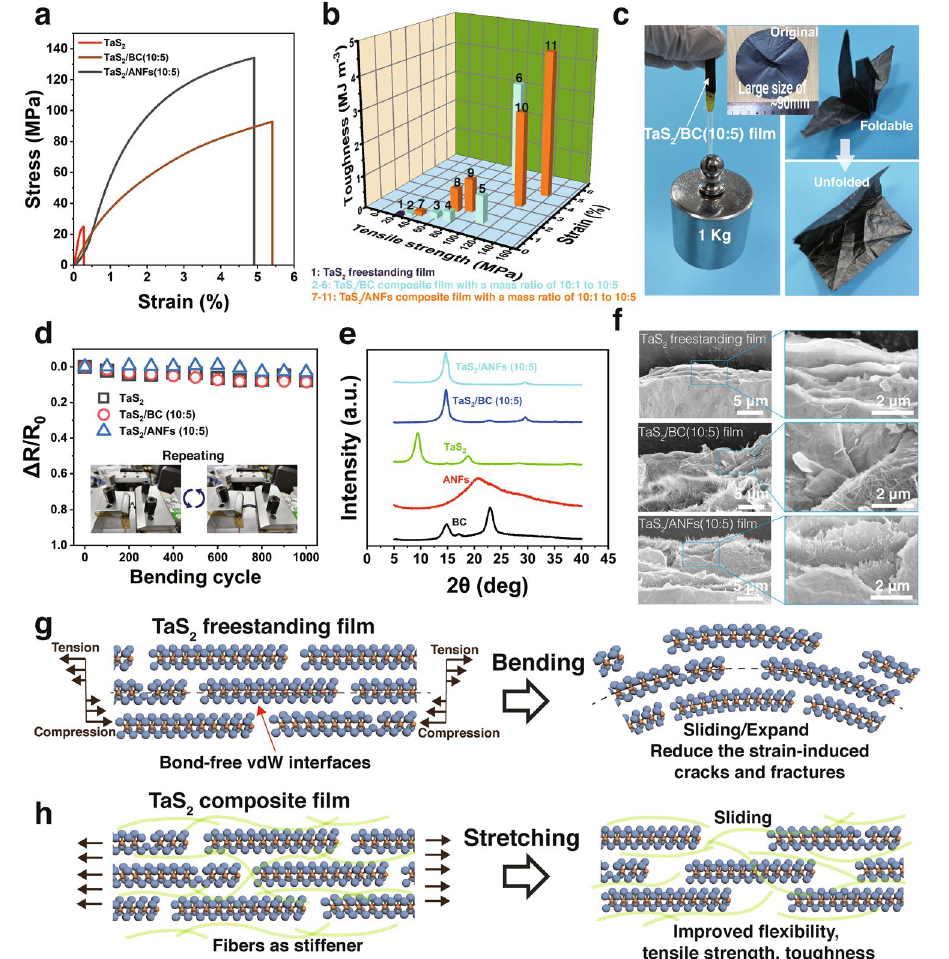
Fig. 5 Mechanical properties of TaS 2 films. a Representative tensile stress–strain curves of TaS 2 freestanding film, TaS 2 /BC (10:5), and TaS 2 / ANFs (10:5) composite films. b Comparison of the strain, tensile strength, and toughness of TaS 2 freestanding film, TaS 2 /BC, and TaS 2 /ANFs composite films, respectively. c Digital images of TaS 2 /BC (10:5) composite films showing their strength and flexibility. d Mechanical and elec- trical stability of